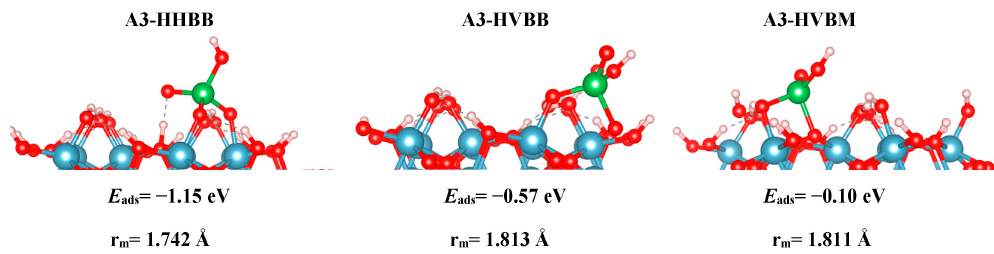
Figure 2. The A3 optimized structures. From left to right: hill–hill bidentate binuclear structure (HHBB), hill–valley bidentate binuclear structure (HVBB), and hill–valley bidentate mononuclear structure (HVBM). Aluminum, oxygen, hydrogen, and arsenic are represented by the colors blue, red, white, and green respectively. E ads and r m are the adsorption energies and averaged As–O surf distances, respectively.